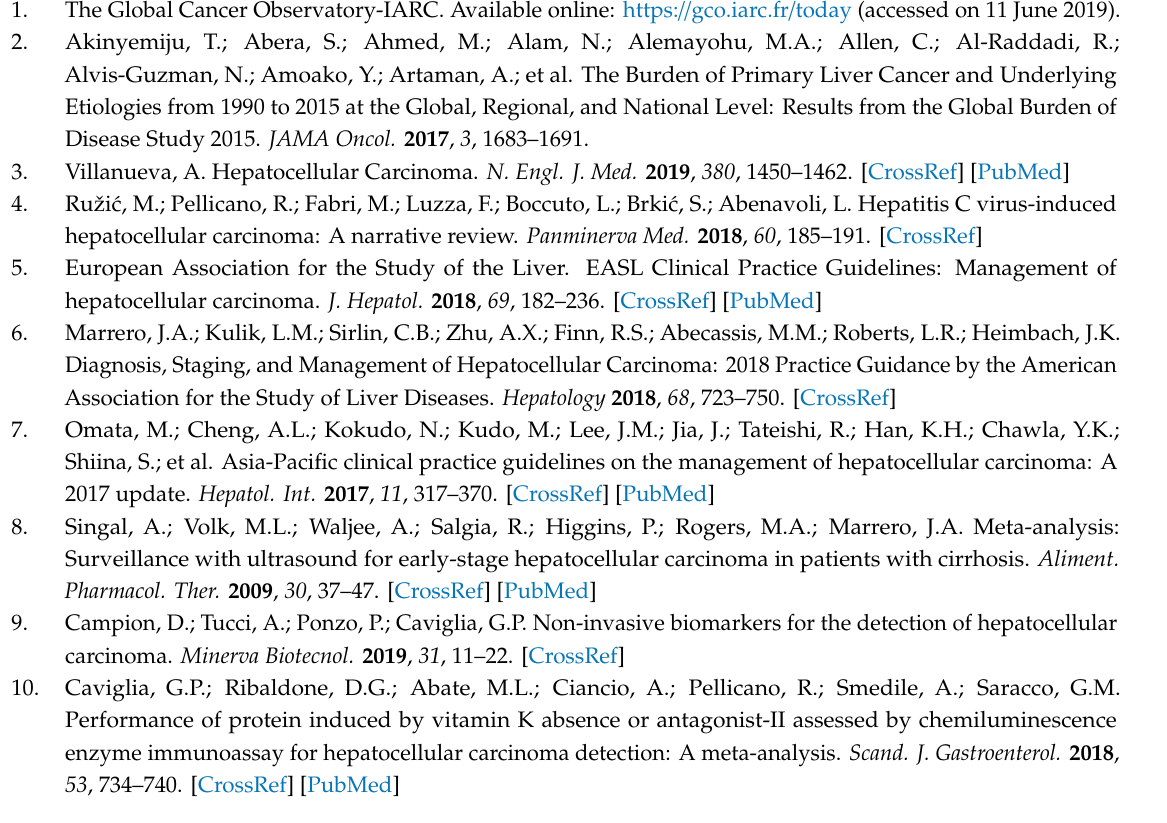
Table S1: Diagnostic accuracy of AFP, PIVKA-II, GPC-3 and AFP + PIVKA-II for the discrimination between patients with cirrhosis and those with HCC, Figure S1: AFP ( A ), PIVKA-II ( B ) and GPC-3 ( C ) serum values in patients with cirrhosis that developed or not HCC during 36 months of